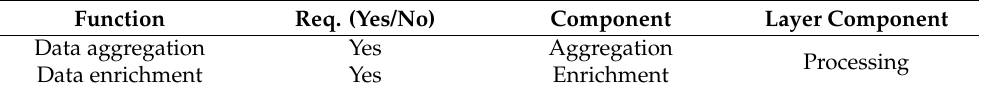
Table 4. Application of CTI Reference Model: Processing Layer.